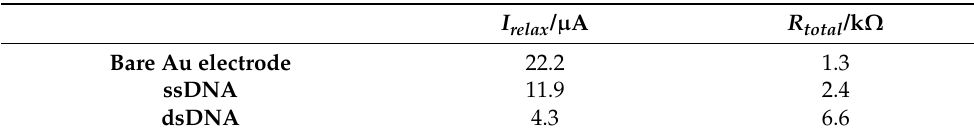
Table 1. Comparison of relaxation currents and total electrical resistance for different electrodes at t ∼ = 1.5